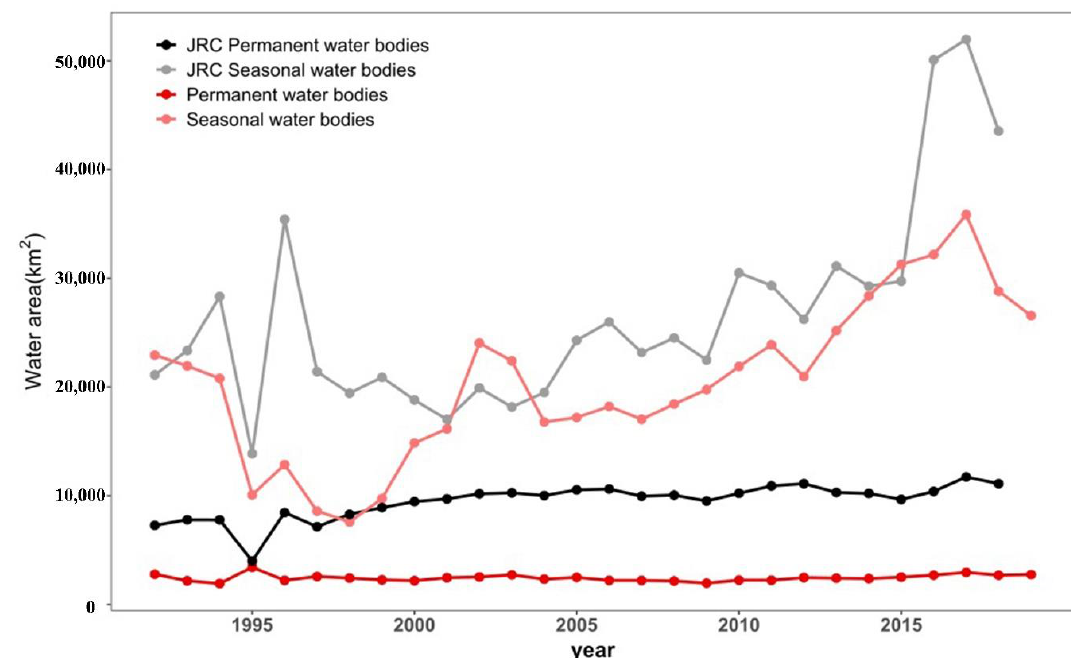
Figure 13. Comparison of TRB’s yearly water bodies area with JRC data.